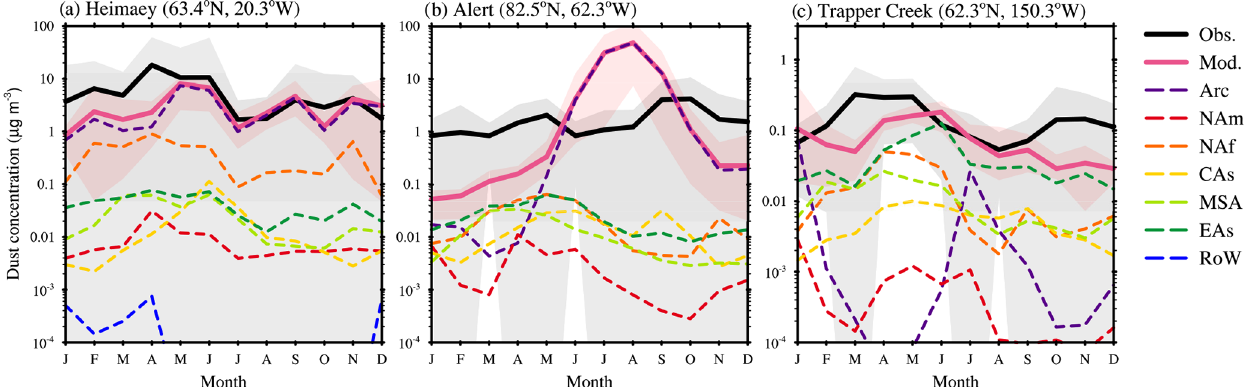
Figure 3. Comparison of measured (black solid line, with gray shading representing standard deviation) and simulated (pink solid line, with pink shading representing year-to-year variability) monthly mean dust surface concentration at three high-latitude stations – (a) Heimaey, (b) Alert, and (c) Trapper Creek. The model results are averaged from the year 2007 to 2011. Contributions from seven tagged sources are shown by colored dashed lines. The locations of the three stations are shown in Fig. 2d. The measurements at Heimaey (Prospero et al., 2012), Alert (Sirois and Barrie, 1999), and Trapper Creek (IMPROVE) are averaged for the years 1997 to 2002, 1980 to 1995, and 2007 to 2011, respectively. The dust concentrations at Trapper Creek only include particles with diameter less than 2.5µm. The other two stations include dust over the whole size